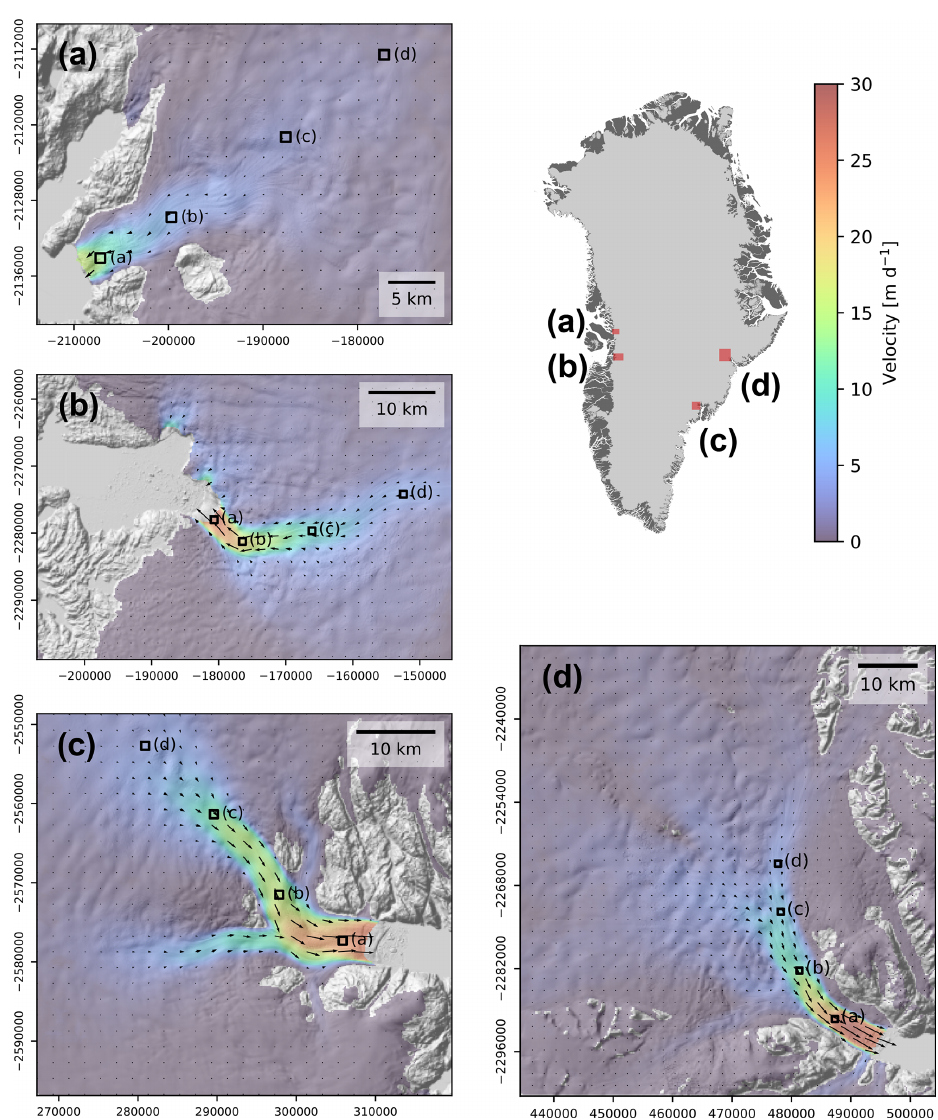
Figure 1. Reference velocity fields (median velocity of repeat-orbit pairs; see Sect. 2.1.2) for the four marine-terminating glaciers presented in this paper, ordered anti-clockwise from north: (a) Store Glacier, (b) Jakobshavn Isbræ, (c) Helheim Glacier, and (d) Kangerlussuaq Glacier. The 1km × 1km sample sites a–d are marked for each glacier – see Table S2 for precise coordinates. Backgrounds are GrIMP DEM hillshades (Howat et al., 2017); coordinates in NSIDC Sea Ice Polar Stereographic North (EPSG:3413). Inset: location in Greenland of all outlet glacier AOIs